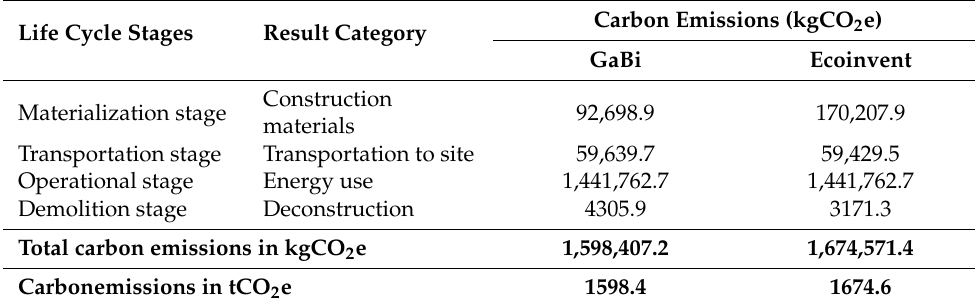
Table 8. Carbon emissions contribution at different life cycle stages.